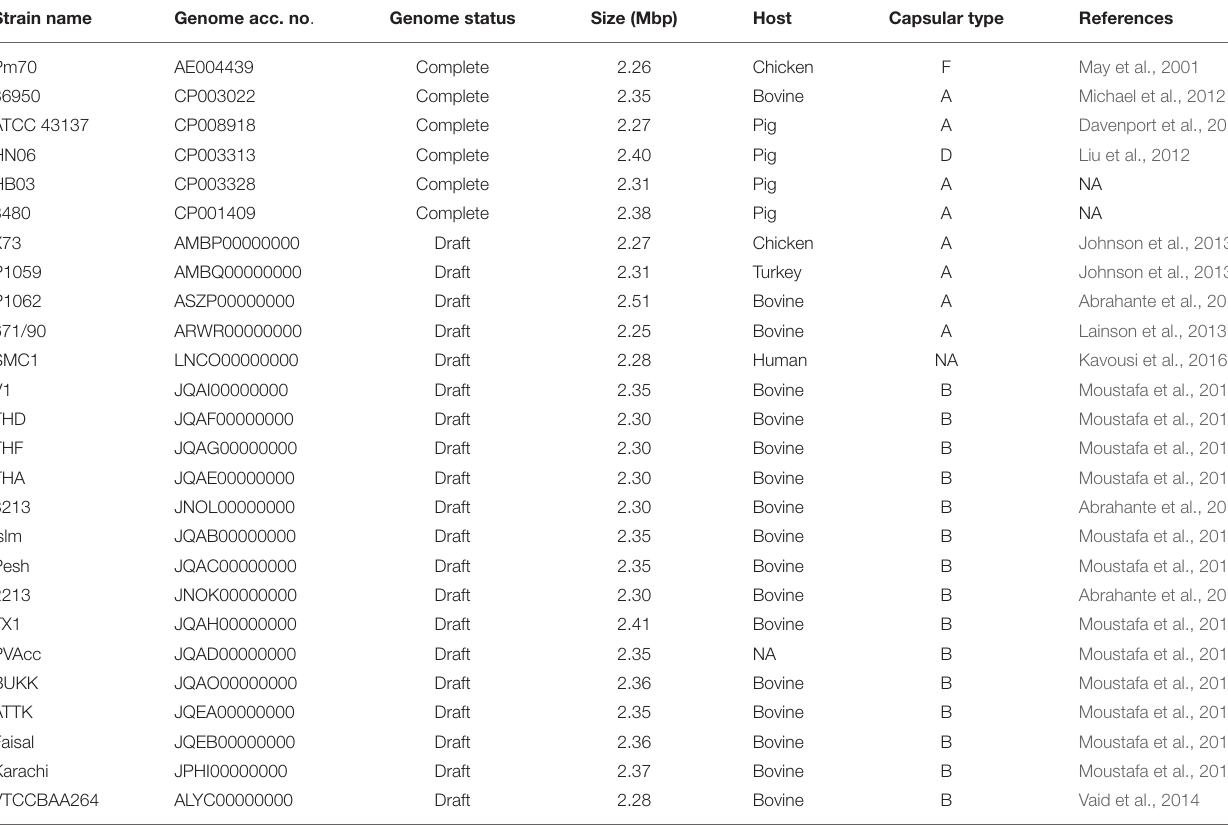
TABLE 2 | Public P. multocida genome assemblies analyzed in this